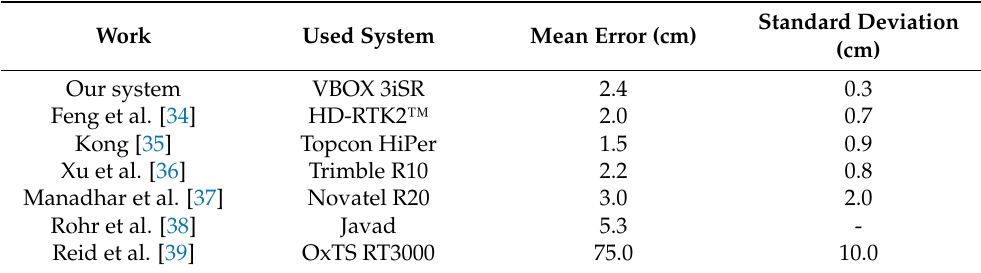
Table 4. Table comparing the performances of our developed stake-out system with other characteri- zations reported in the literature in terms of mean error and standard